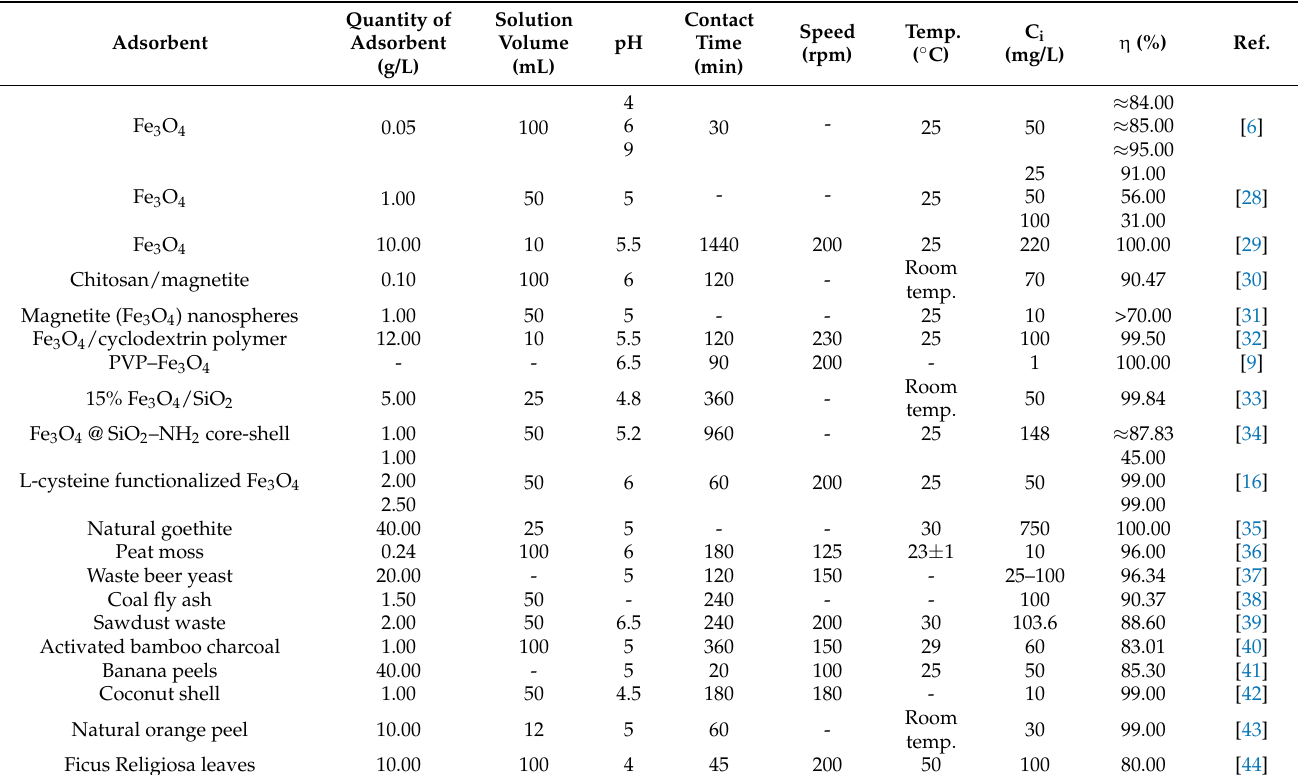
Table 1. Materials used for lead removal from